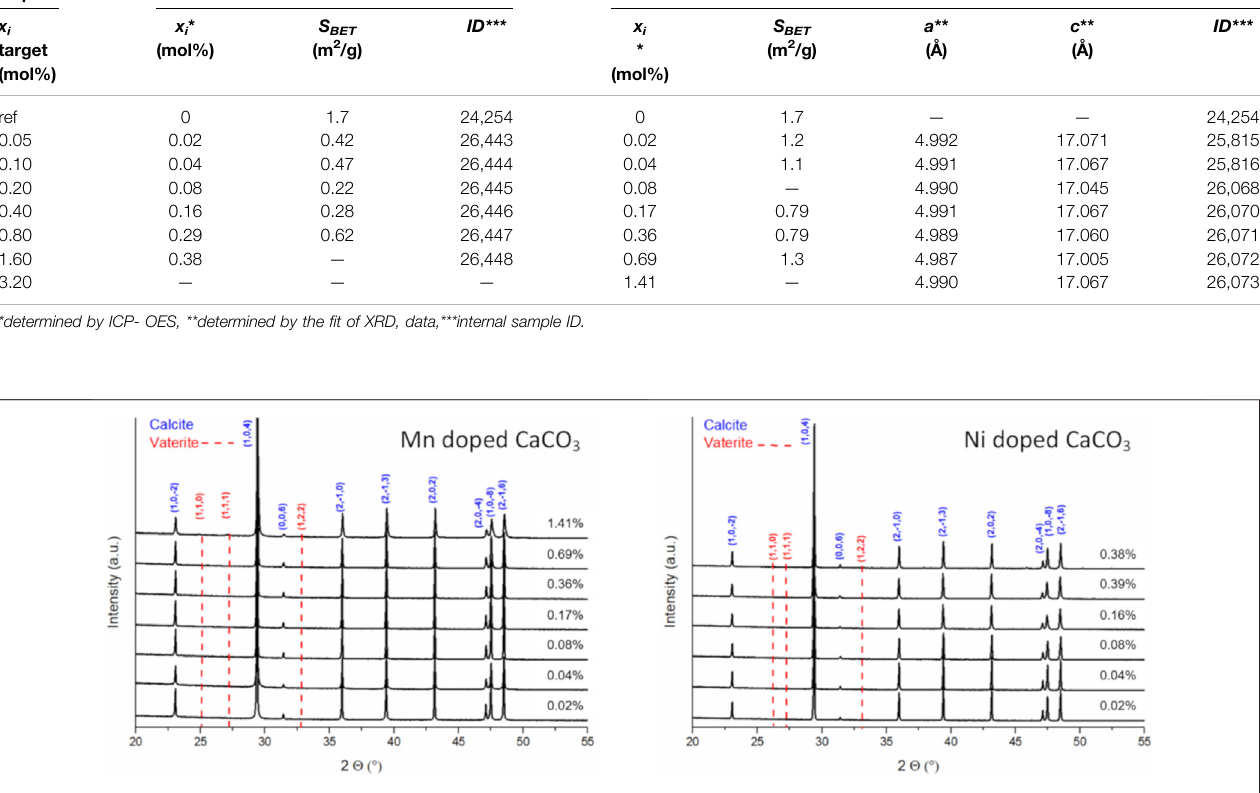
Frontiers in Chemistry |